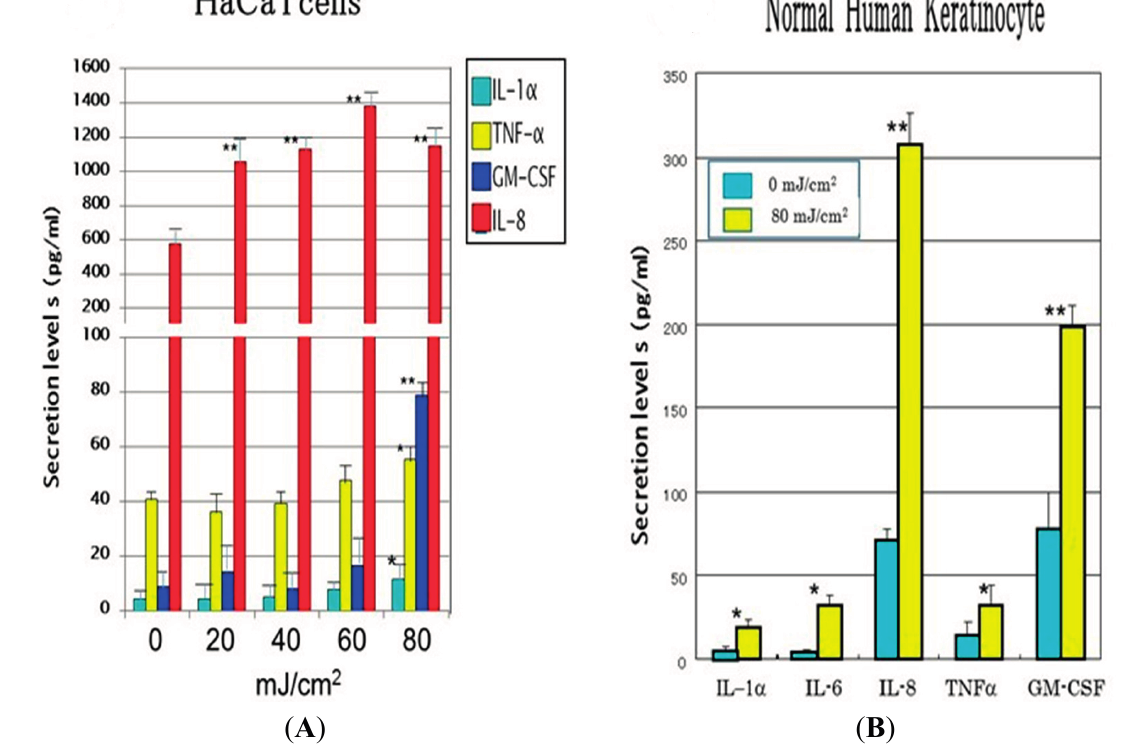
Figure 2. Secretion levels of cytokines (pg/mL) in the medium from HaCaT cells or HPK 72 h after UVB irradiation at 0–80 mJ/cm 2 . ( A ) HaCaT cells; ( B ) HPK. Cultured HaCaT cellsor HPK were exposed to UVB at the indicated doses and secretion levels of cytokines were measured by ELISA kit at 72 post-irradiation. Values are means ± S.D. derived from three independent experiments. ** p < 0.01, * p < 0.05 ( vs. 0 mJ/cm 2